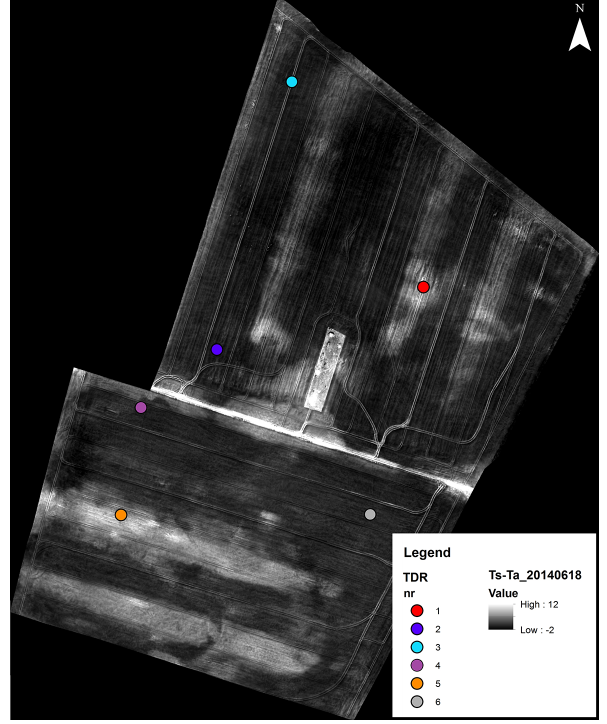
Figure D1. The location of the six TDR probes on the T S − T A map from 18